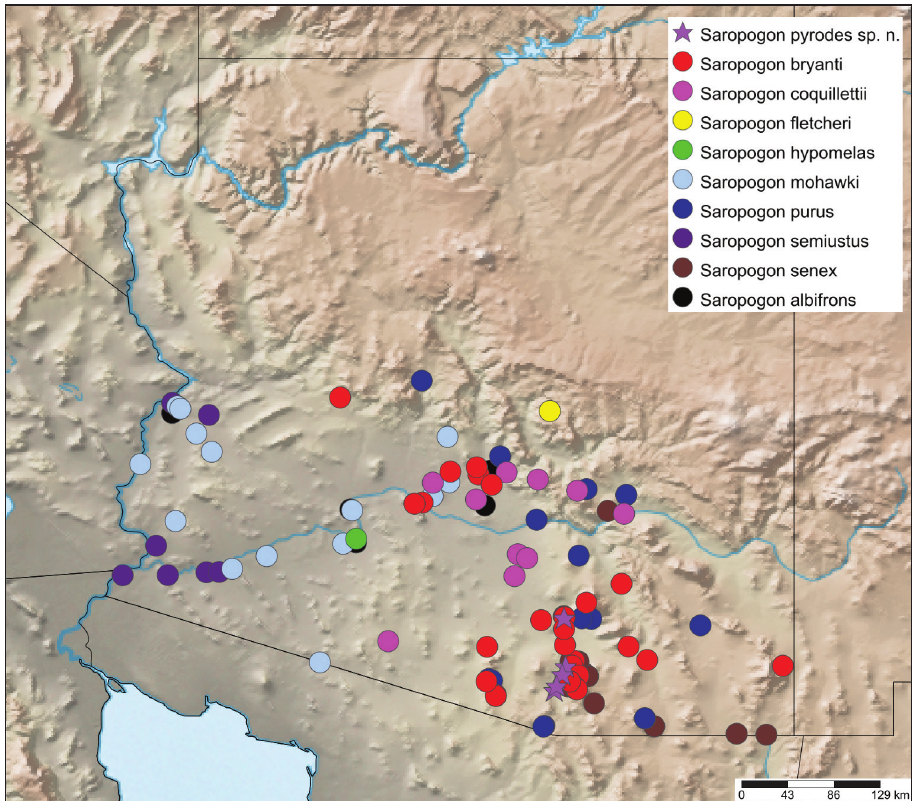
Figure 26. Focused map of the Arizona distribution of Nearctic Saropogon (Diptera: Asilidae). Map cre- ated with SimpleMappr on January 25, 2022, and available at: